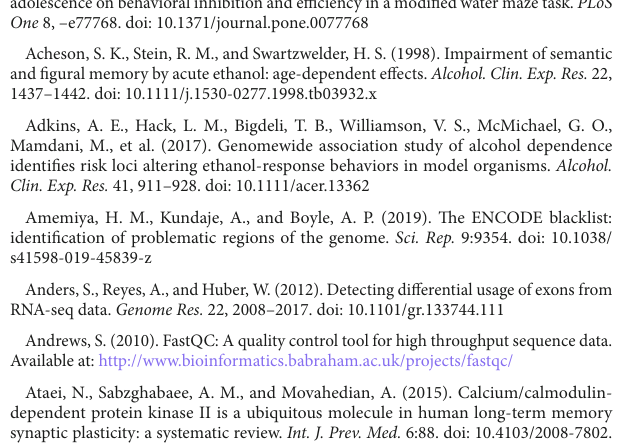
SUPPLEMENTARY FIGURE 1 H3K36me3 ChIP antibody validation and sequencing coverage. A. H3K36me3 antibody (Active Motif) was validated using positive (Aldoa) and negative (Chr12dsrt) primers to visualize regions of expected high and low binding, respectively, and was compared to IgG (Millipore) to identify enrichment over non-specific binding. Graph shows representative sample. Aldo1a F: AGGTGGATGCACCATCACATT, Aldo1a R: TGCATTAGAGATGCGGAGCA, Chr12dst F: CACTGACACCTGACCTCGAT, Chr12dsrt R: ATGCCACAGCCCAAGTATGG. B. Representative ChIP read coverage of three genes that showed ethanol-induced changes to H3K36me3: Cacna1b, Lrrk2, and Ryr2. SUPPLEMENTARY TABLE 1 Differential gene expression results for male and female PFC. SUPPLEMENTARY TABLE 2 Gene ontology analysis for the 342 genes differentially expressed in the PFC after adolescent binge ethanol in males only, p < 0.05. SUPPLEMENTARY TABLE 3 Gene ontology analysis for the 376 genes differentially expressed in the PFC after adolescent binge ethanol in females only, p < 0.05.